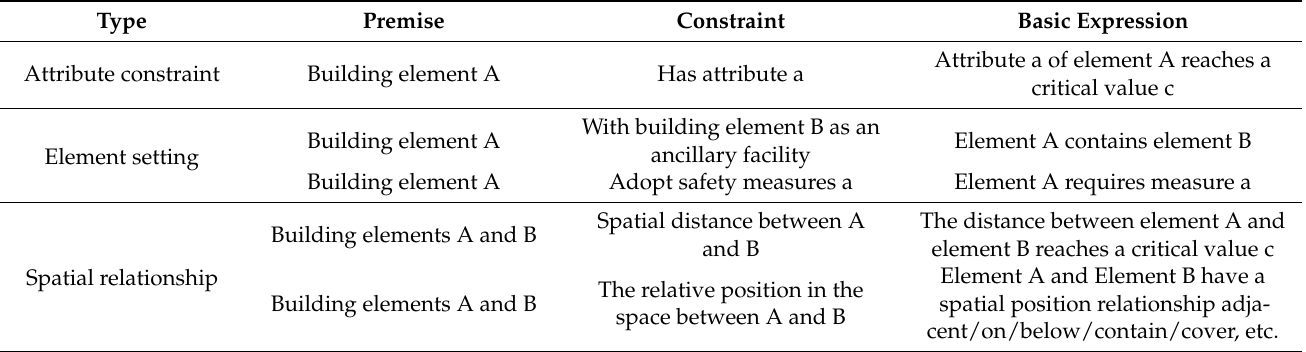
Table 1. Knowledge types of a building safety design code.